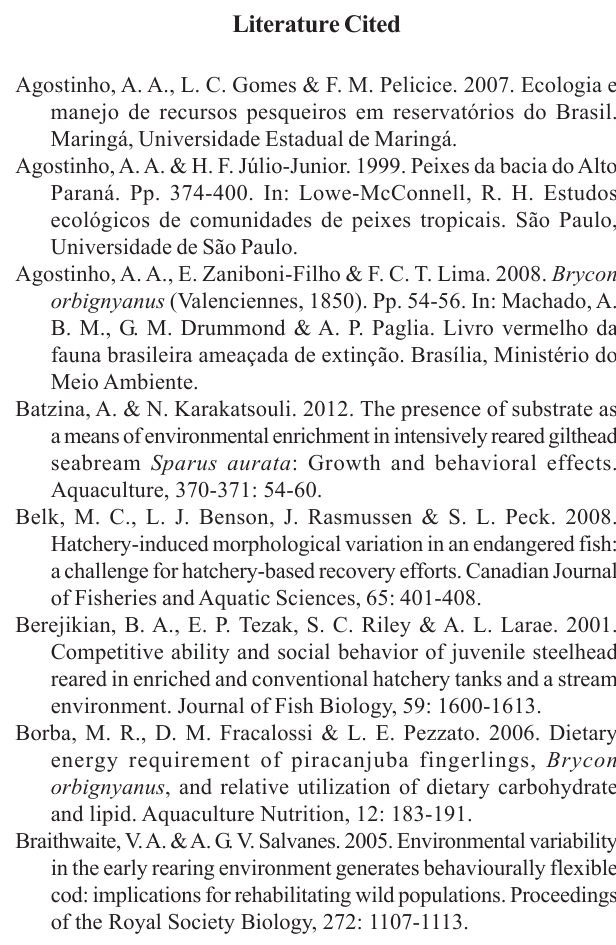
Fig. 7. The log of the distance from the centroid plus 1 [log (DC+1)] for Prochilodus lineatus and Brycon orbignyanus . The ANOVA was significant for both species (p < 0.0001), demonstrating significant differences among the treatments. The results of the Tukey tests, specifying which DCs were different from each other, are demonstrated by the letters A, B, and C. Different letters indicate significant differences among the